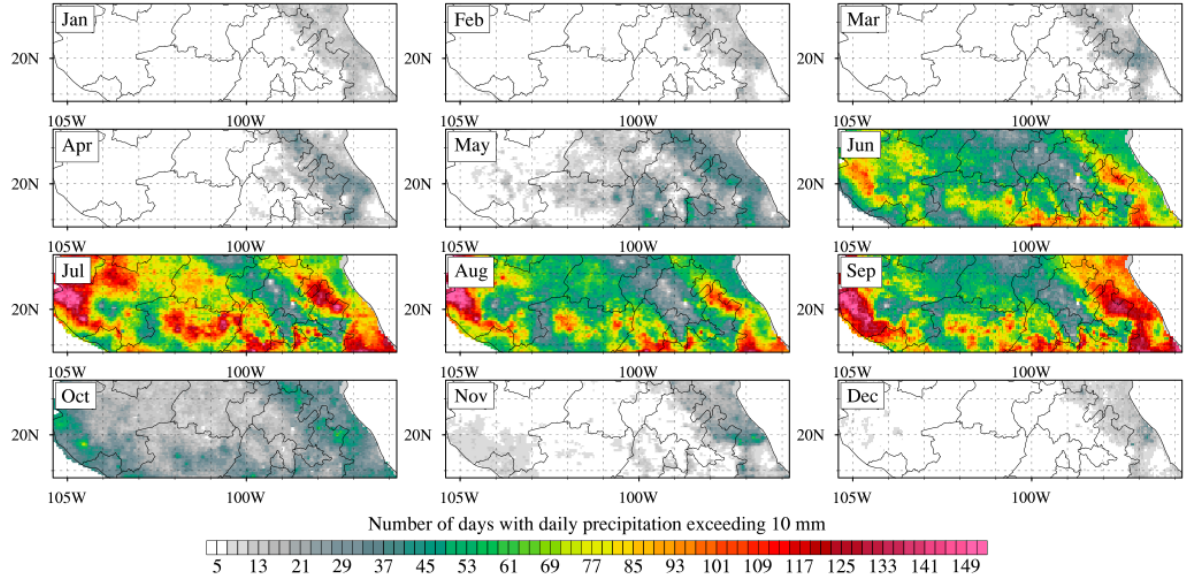
Figure 4. Monthly distribution of the total number of days with daily precipitation exceeding 10 mm based on Climate Hazards Group Infrared Precipitation with Station (CHIRPS) data (2008–2017) with a horizontal resolution of 0.05